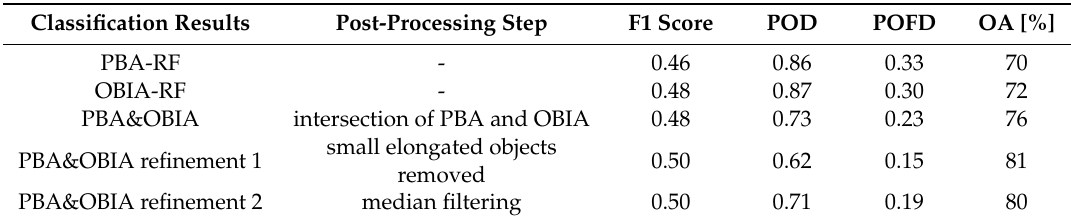
Table 7. Accuracy assessment for training and testing strategy 2 with the accuracies acquired after post processing steps (Ro˙zn ó w Lake